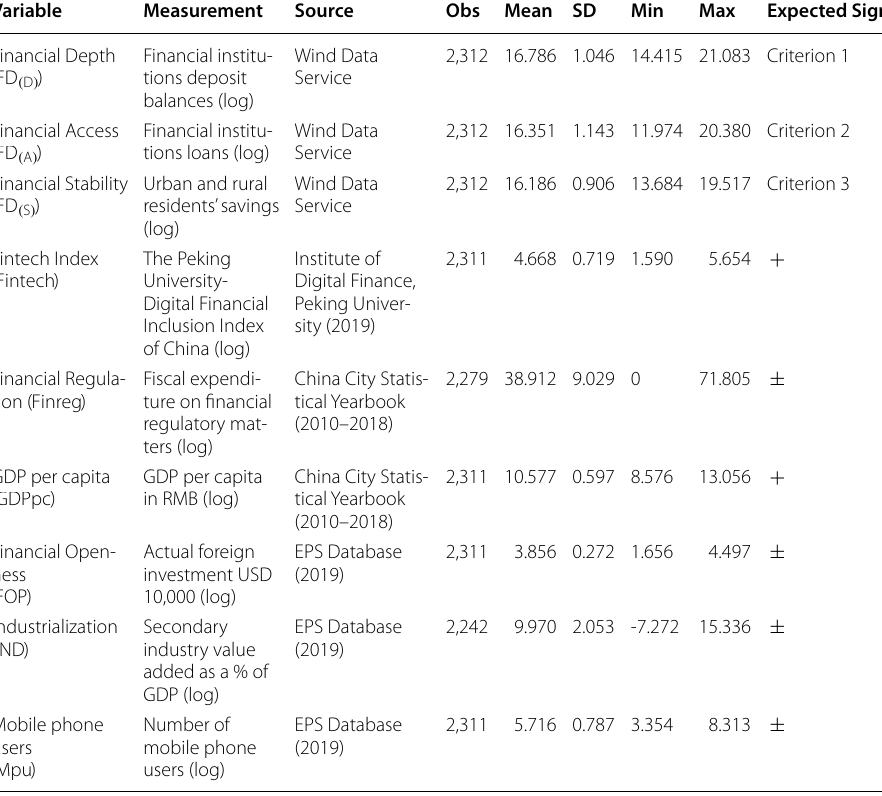
Table 2 Data characteristics and summary